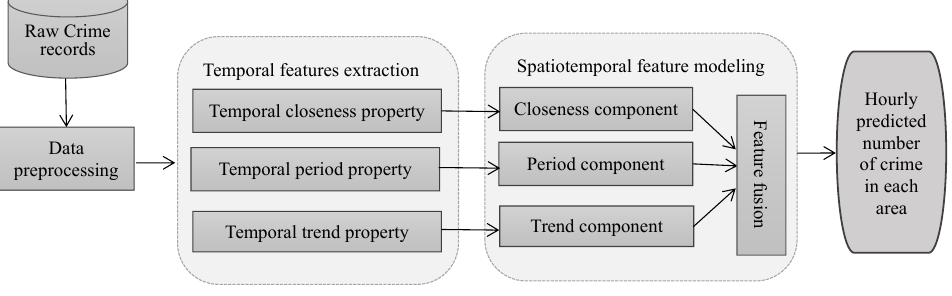
Figure 2. Framework.